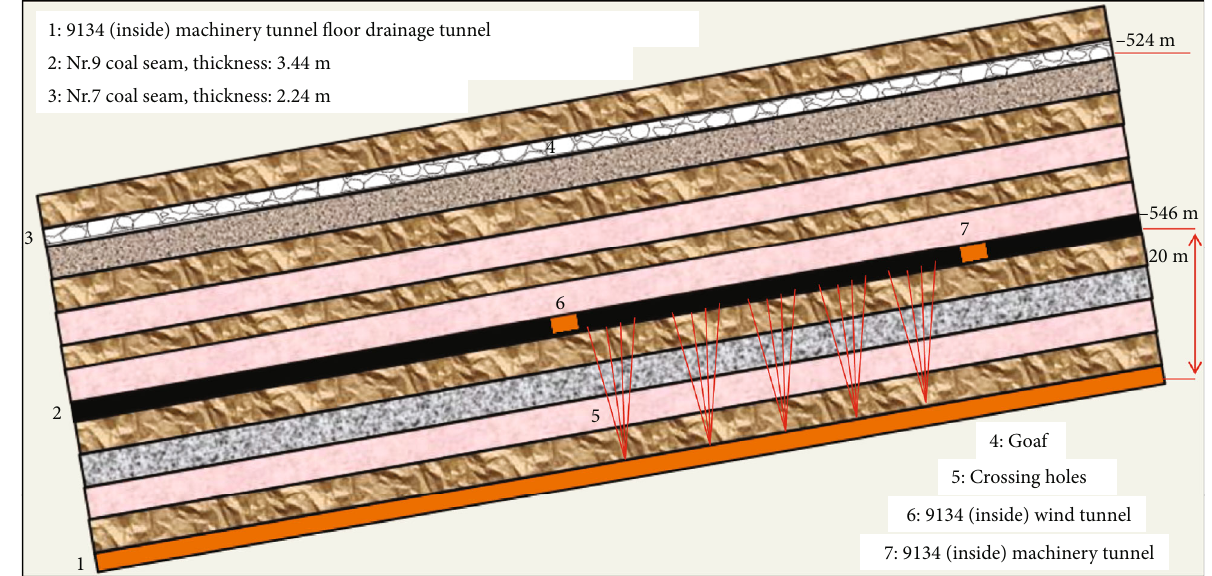
Figure 2: Illustration of coal seam occurrence and roadway arrangement in the experimental area.